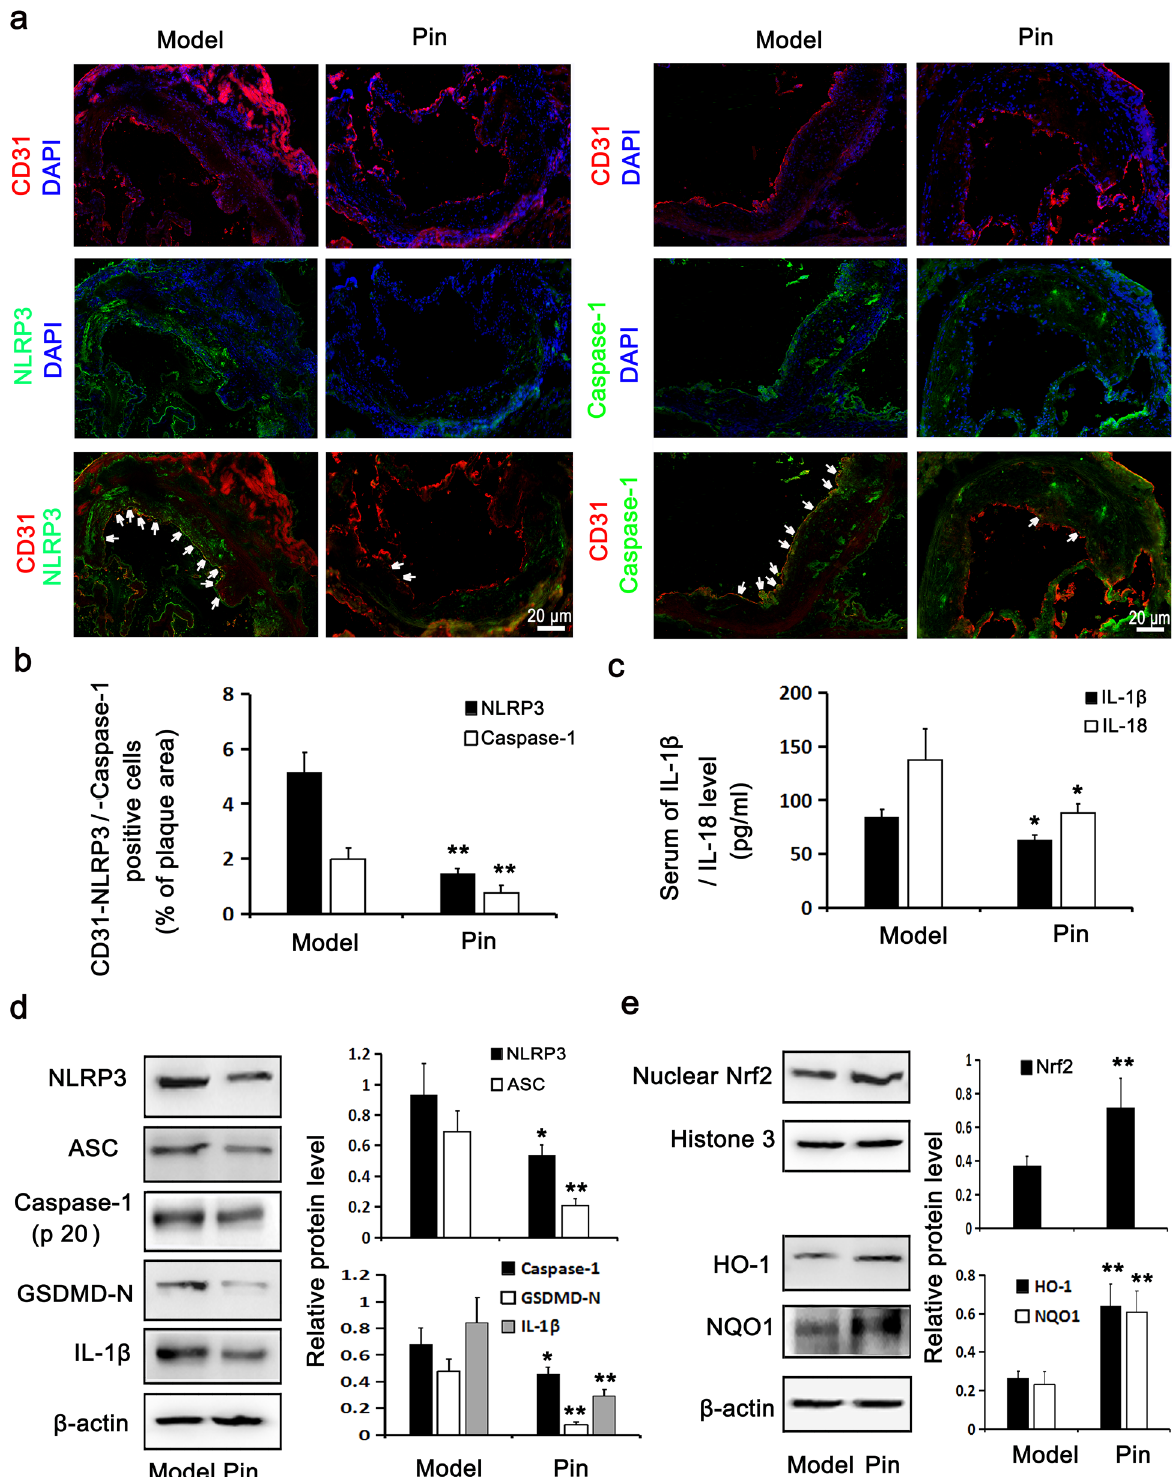
Figure 8. Role of Pin in the expressions of pyroptosis-related molecules and Nrf2/HO-1 axis in Apoe –/– mice. The immunofluorescence stained images and quantitative analysis of CD31-NLRP3 and CD31-Caspase-1 positive cells (white arrow) in the aortic roots were displayed on ( a,b ). Red: CD31; Green: NLRP3 and Caspase-1; Blue: nuclei. Scale bar = 20 µm. ( c ) Showing IL-1β and IL-18 levels in the serum, assayed through ELISA. WB assay showing the protein expression levels of pyroptosis-related ( d ) and Nrf2/HO-1 axis-related molecules ( e ) in the aortic arches. The data are described as the mean ± SD of at least 3 different experiments. * P < 0.05; ** P < 0.01 vs. model